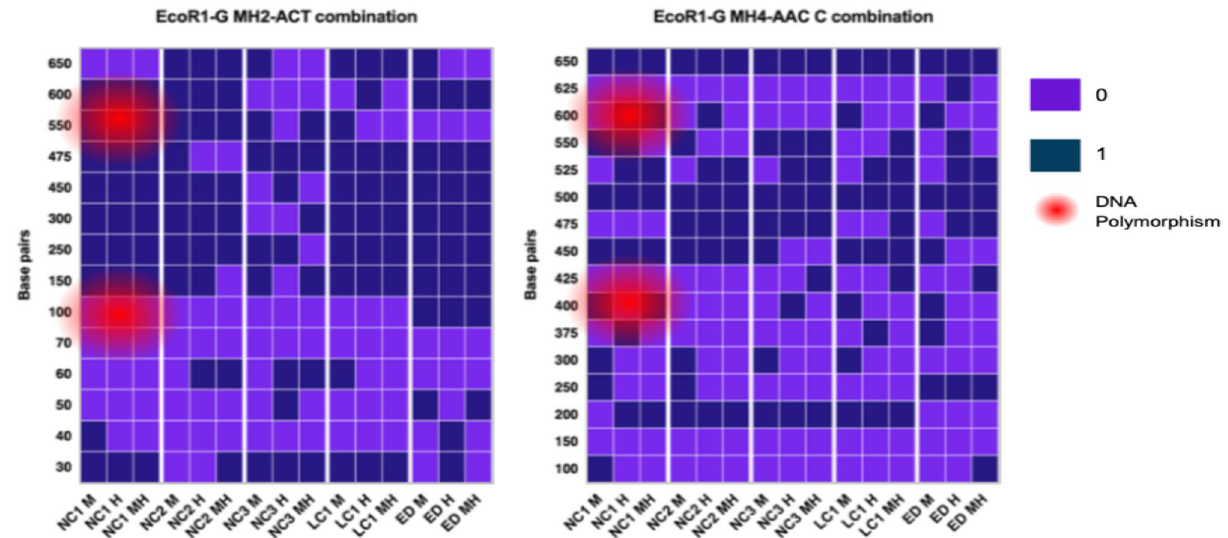
Figure 2. Heatmaps represents the example of methylation sensitive amplification polymorphism (MSAP) profiles in DNA methylation patterns observed in NC1 (node culture-derived shoots from liquid medium), NC2 (node culture-derived shoots from semi-solid medium), NC3 (node culture-derived plants from greenhouse), LC1 (leaf culture-derived plants from greenhouse) and ED (cutting propagated plants from greenhouse) of lingonberry cultivar Erntedank, obtained by using the primer combination EcoR1 -G/MH2-ACT and EcoR1 -G/ MH4-AAC C. The GraphPad Prism (version 8.0.0) was used to generate the heatmap. M, H, and MH refer to the digestion with combinations of EcoR1 + MspI (M), EcoR1 + HpaII (H), and EcoR1 + MspI + HpaII (MH), respectively. “0” refers to the absence of methylated DNA band, and “1” refers to the presence of methylated DNA band. In NC1, DNA bands (marked by red spot) present in M digestion lanes but not in H lanes indicate internal cytosine methylation in EcoR1 -G/MH4-AAC C combination. NC1 banding pattern (marked by red spot) absent in M lane in EcoR1 -G/MH2-ACT combination indicates DNA methylation polymorphisms. Likely, in NC1 banding pattern (marked by red spot) present in H digestion lane but not present in M lanes indicates external cytosine methylation in EcoR1 -G/MH4-AAC C combination. On the other hand, in NC1 banding pattern (marked by red spot) present in both M and H lane of EcoR1 -G/MH2-AAT combination indicates